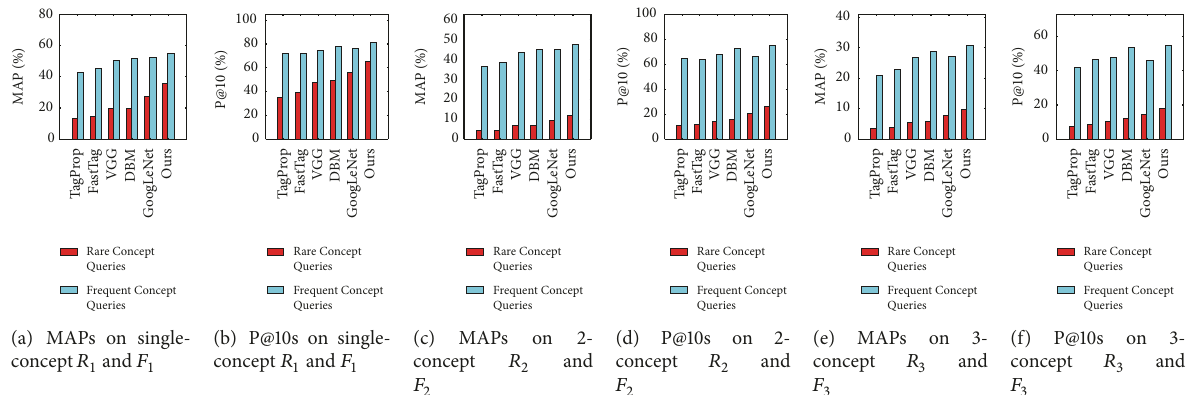
Figure 4: MAPs and P@10s (%) of semantic image retrieval for rare concepts and frequent concepts on MIR Flickr 2011.